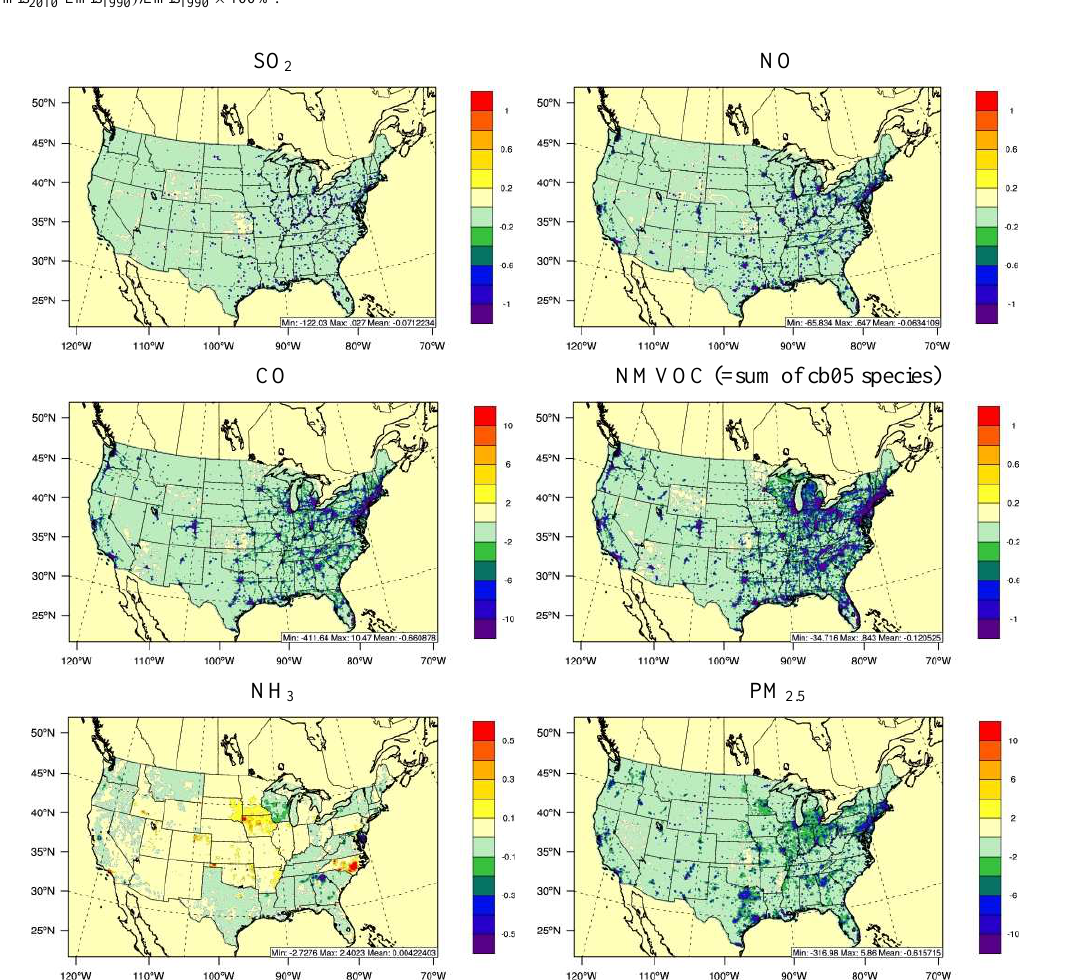
Fig. 8. Changes in emission rates over the 12km × 12km CONUS domain from 1990 to 2010 (unit:moless − 1 grid for gaseous species, Fig. 8 Changes in emission rates over the 12×12km CONUS domain from 1990 to 2010 (unit: moles/s·grid for gs − 1 grid for PM 2 . 5 ) gaseous species, g/s·grid for PM 2.5 )